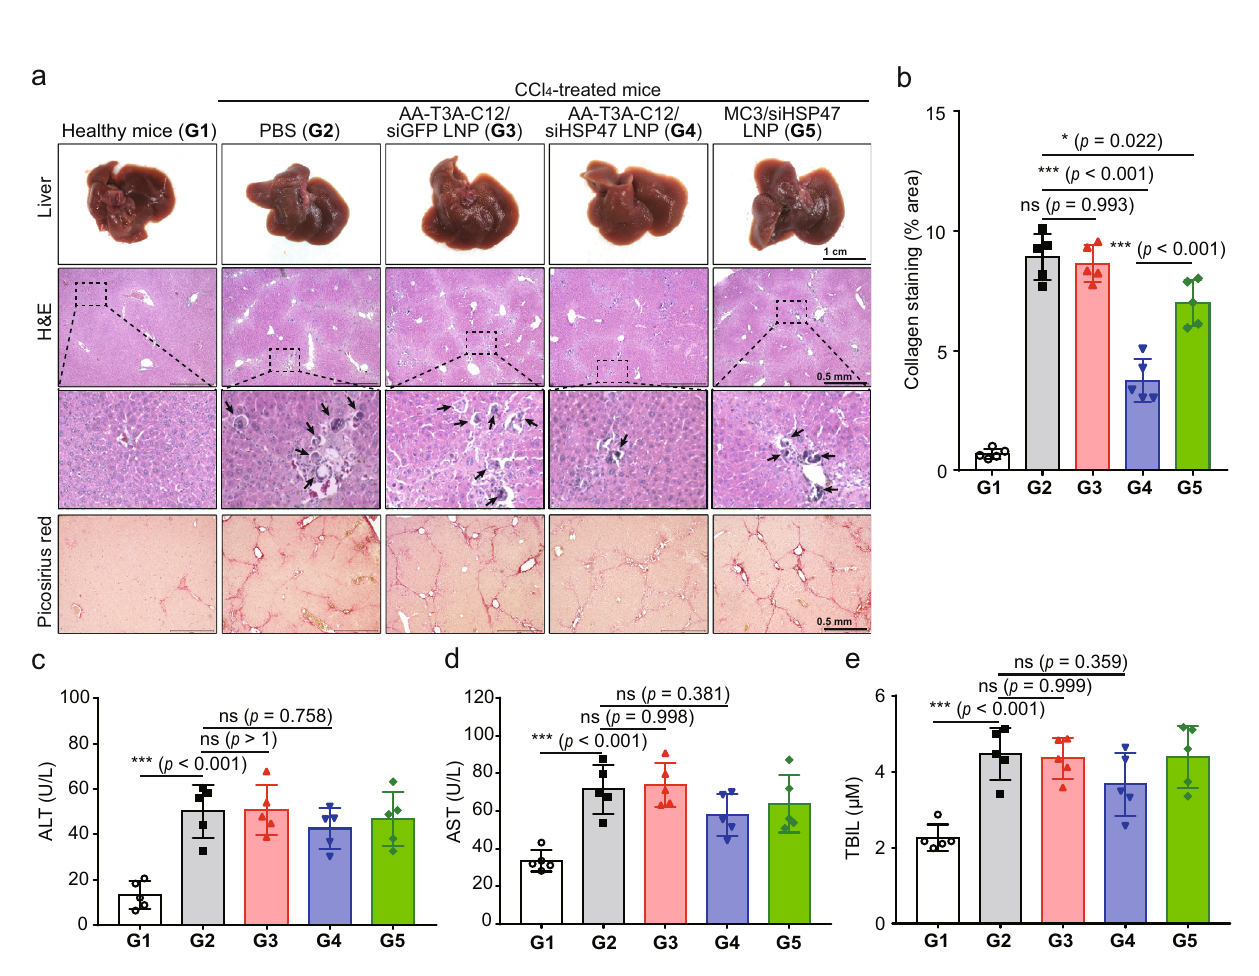
Fig. 6 | Macroscopic, histopathological, and biochemical analysis of liver fi brosis. a Representative images of livers and liver sections stained with hema- toxylin and eosin (H&E) or Picrosirius red (representative dataset from n =5/ group). Black arrows indicate apoptotic hepatocytes. b Morphometric quanti fi ca- tion of Picrosirius red stained areas by ImageJ software ( n